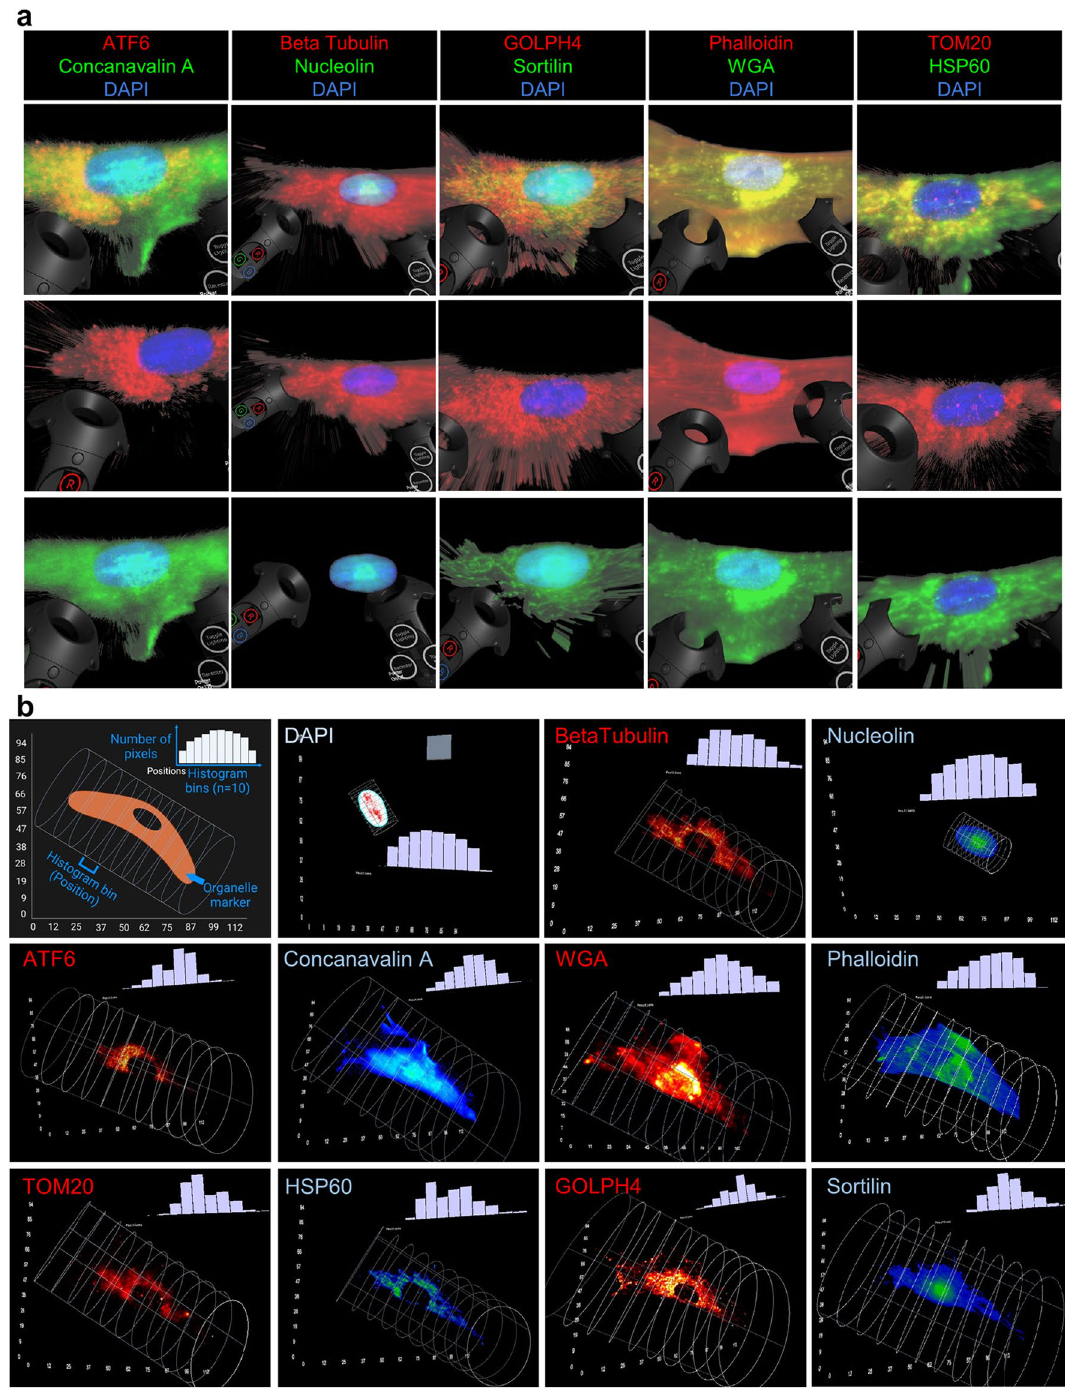
Figure 7. Virtual reality-based visualization and analysis of organelle imaging data in MSCs. ( a ) Visualization of organelle protein images (10 markers) for one BM MSC in ConfocalVR 62 . For each cell, the top shows the RGB image of the combined markers, while the bottom two show a single marker image in either red or green with DAPI. Different organelle markers are illustrated across the columns. Merged images are shown in the first row. Column 1: ATF6 (middle row) & Concanavalin A (bottom row), Column 2: Beta Tubulin (middle row) & Nucleolin (bottom row), Column 3: GOLPH4 (middle row) & Sortilin (bottom row), Column 4: Phalloidin (middle row) & WGA (bottom row), Column 5: TOM20 (middle row) & HSP60 (bottom row). Handset toggle switches used to interact with the image are shown on the left and right sides. ( b ) Visualization of organelle protein images (10 markers) for one BM MSC in Genuage 63 . The histogram of pixel count in 10 cylindrical bins (shown in white) of width 12.5 pixels (108 nm/ pixel, bin width 1.354 µm) was plotted in the software. The top left image is an illustration explaining how cells are binned across the length to gauge spatial variability. In each box, red and blue colors illustrate the marker according to the upper left label. Beta Tubulin, ATF6, TOM20, and GOLPH4 show discontinuous regions of signal, supported by the uneven histograms, while the other signals are more continuous with more Gaussian